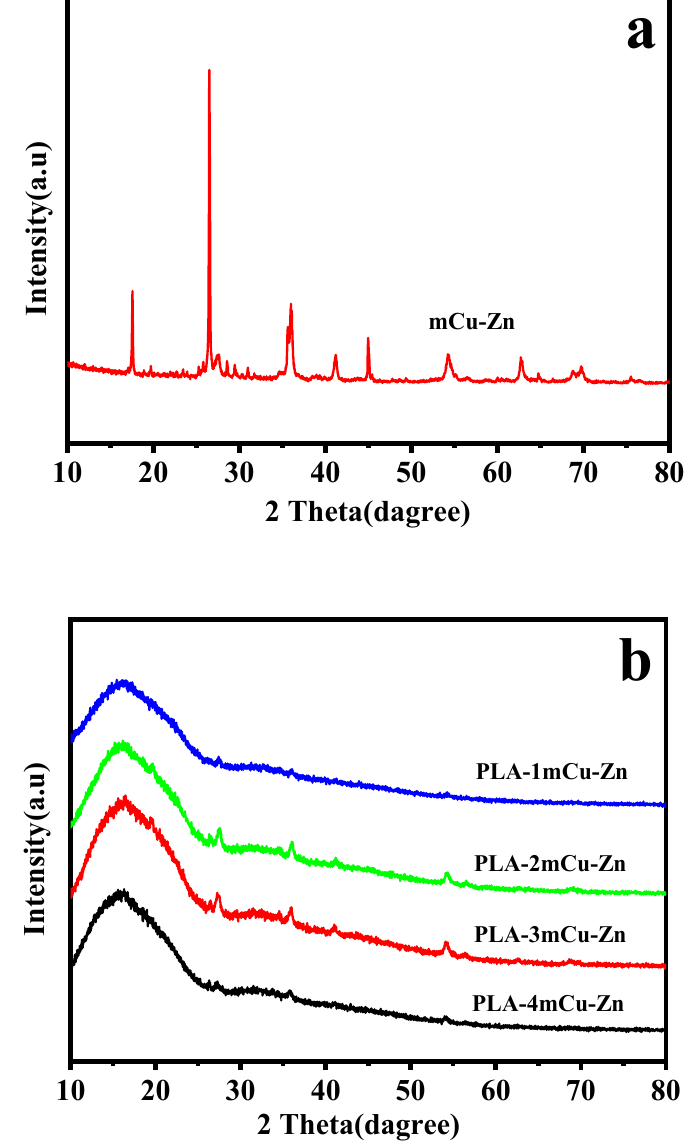
Figure 10. The X ‐ Ray diffraction (XRD) spectra of mCu ‐ Zn ( a ) and mCu ‐ Zn/PWF/PLA composites with 5 wt.% PWF ( b ). 5 wt.% PWF ( b